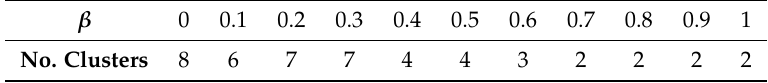
Table 7. Sensitivity of parameter β while l = 3 and τ = 0.5 to evaluating the number of clusters that can be automatically generated by